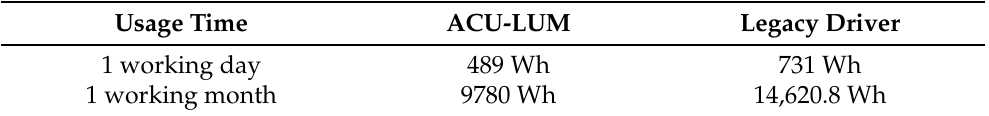
Table 5. Estimated energy consumption of 10 ACU-LUM and 10 legacy drivers when powering the luminaire in the proposed periods.